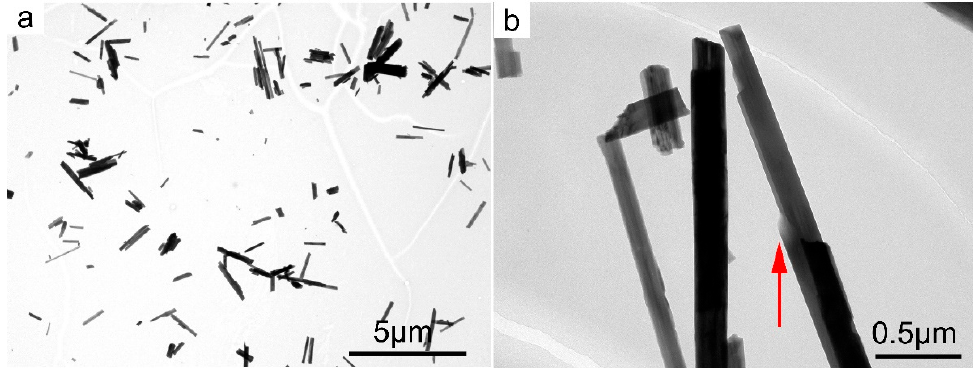
Figure 7. ( a ) TEM micrographs of Ni-doped tremolite run TN8 (800 °C, 2.4 kbar, 16 day); ( b ) fibers with different widths. Note structural defects along their elongation direction; the red arrow indicates edges at 120°.